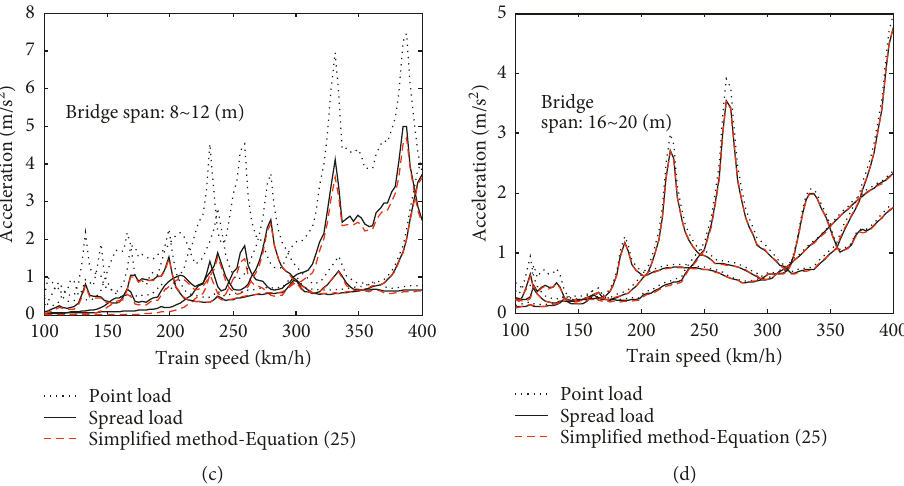
16 ∼ 20m (ML model), (c) (cid:29)